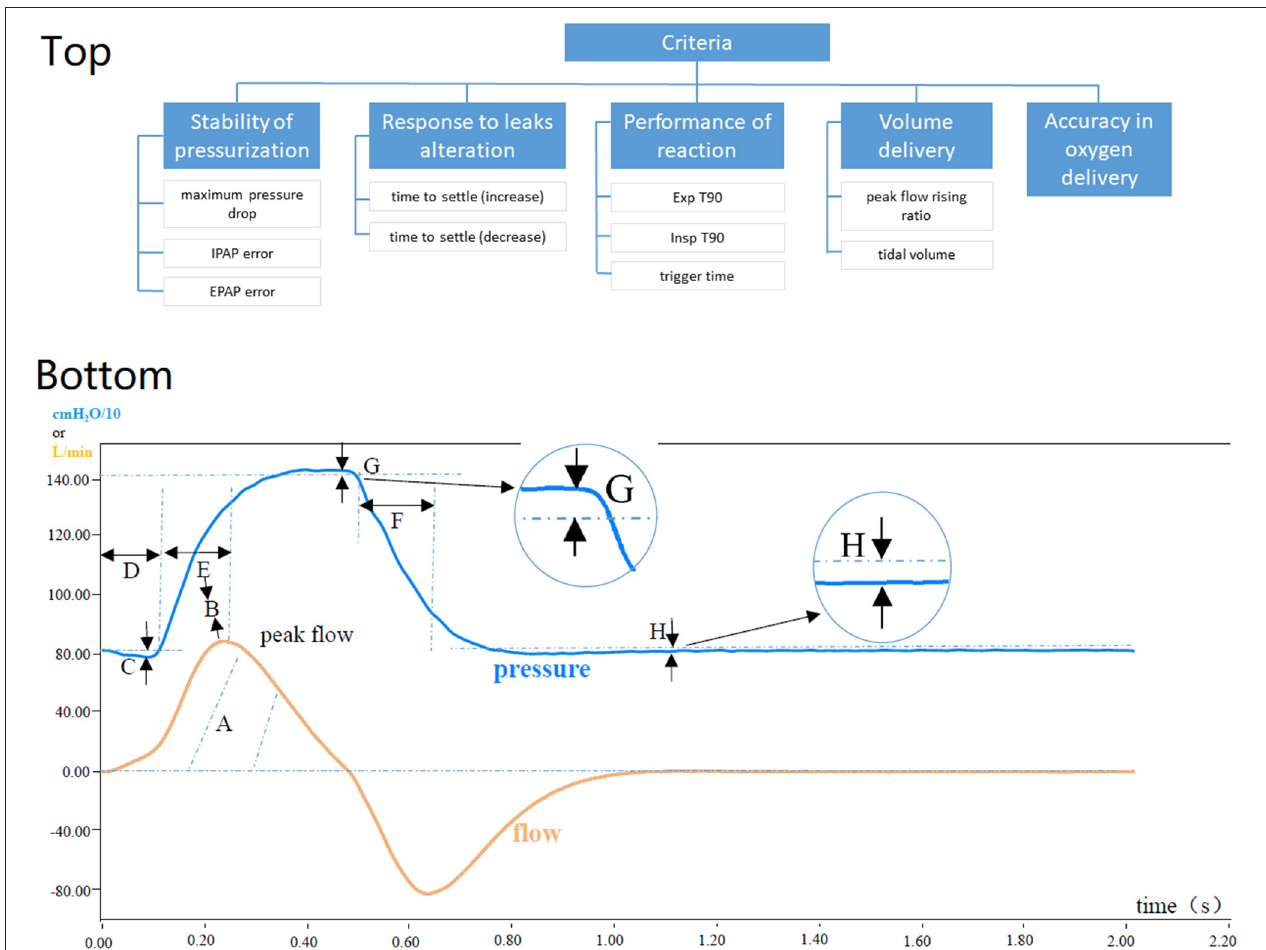
FIGURE 1 | (Top) Illustration of the analytic hierarchy process hierarchy. (Bottom) explanation of the evaluated parameters. (Top) EPAP, expiratory positive airway pressure; IPAP, inspiratory positive airway pressure; Exp T90, the time to accomplish 90% of the drop from peak pressure to EPAP; Insp T90, the time to accomplish 90% of the rise to IPAP. For detailed explanation of the nodes, please refer to the text. (Bottom) A, Tidal volume: The volume of gas the user inhales; B, Flow efficiency: Peak flow divided by the length of Insp T90; C, Maximum pressure drop: Deflection of airway pressure from baseline (EPAP) to Pmin; D, Time to trigger: Point in time at which airway pressure has returned to baseline (EPAP) after a downward deflection; E, Insp T90: The time to accomplish 90% of the rise to IPAP; F, Exp T90: The time to accomplish 90% of the drop from peak pressure to EPAP; G, IPAP error: The difference between Ppeak and the set IPAP; H, EPAP error: The difference between the positive end-expiratory pressure and the set